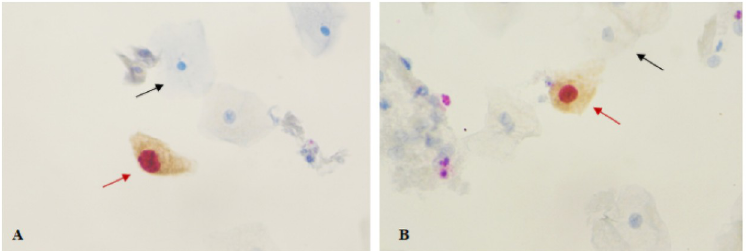
Fig 1. Examples of p16/ki-67 dual stained cells.